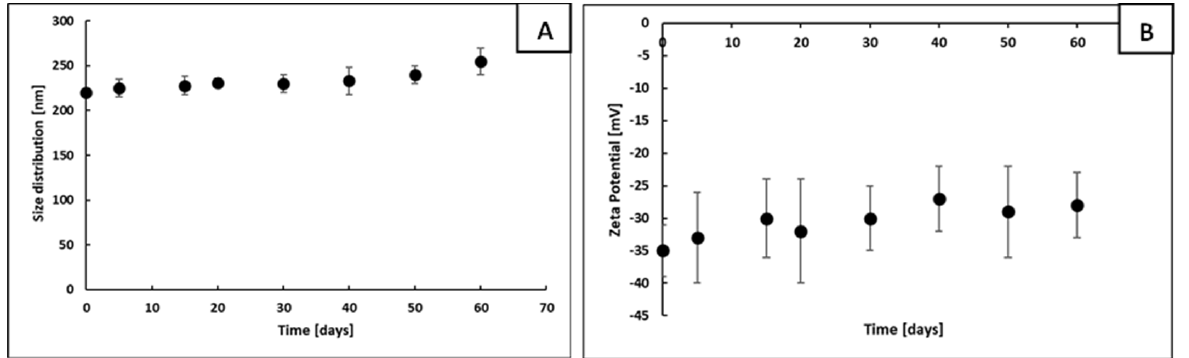
Figure 2. Dependence of size ( A ) and zeta potential ( B ) of Ni@Ag NPs on the storage time measured by DLS and by microelectrophoretic method, respectively.